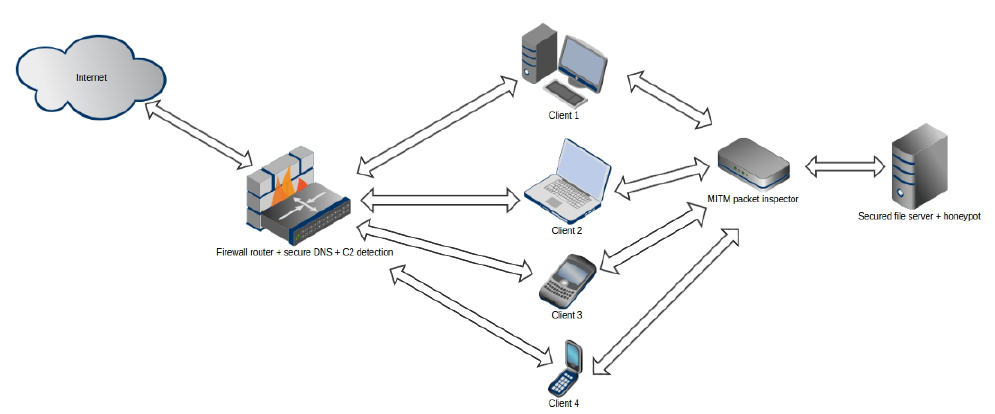
Figure 11. Network topology of the ARDS